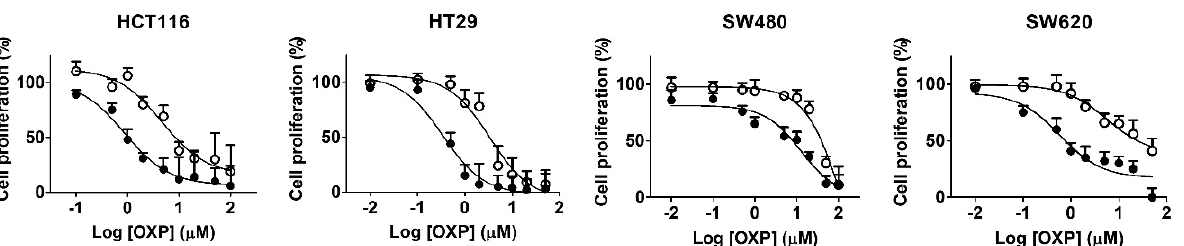
) CRC cells of HCT116, (cid:35)